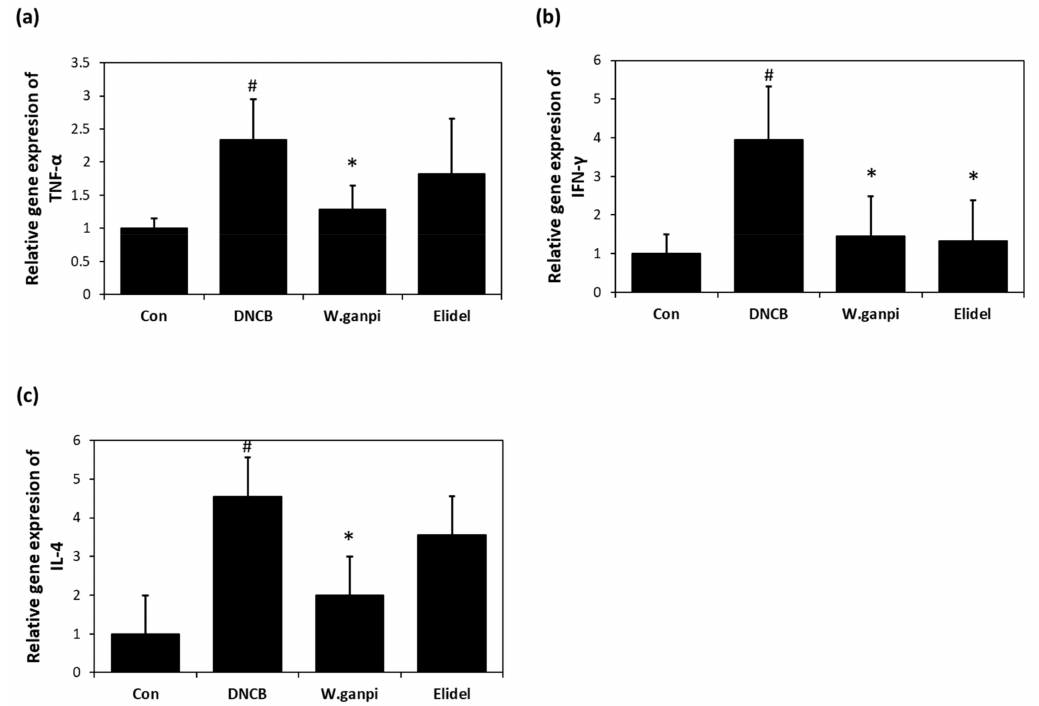
Figure 5. Effects of WGE on the relative gene expression of cytokines TNF- α , IFN γ , and IL-4 DNCB sensitized mouse dorsal skin. ( a ) The mRNA expression of TNF- α ; ( b ) The mRNA expression of IFN γ ; ( c ) The mRNA expression of IL-4 # p < 0.05 vs. the CON group; * p < 0.05 vs. the DNCB